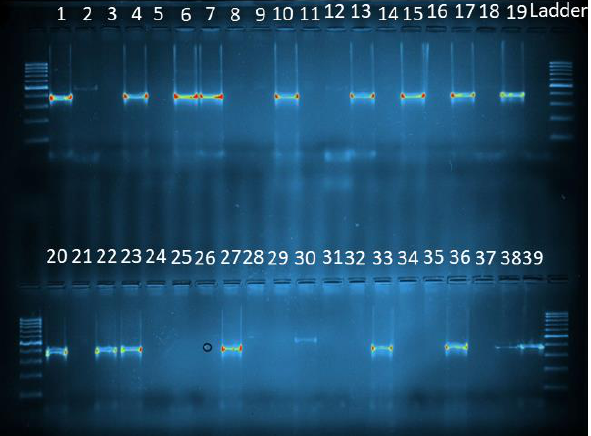
Figure 4. Diagnostic PCR using the primers set for P. falciparum and P. vivax . 1: positive control P. falciparum (395 bp); 2: positive control P. vivax (499 bp); 3: negative control; 4 – 39: samples; Ladder = 100 bp (Solis BioDyne).